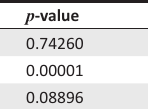
TABLE 4: Regression summary for dependent variable (elevated intrapreneurial behaviour 1st canonical